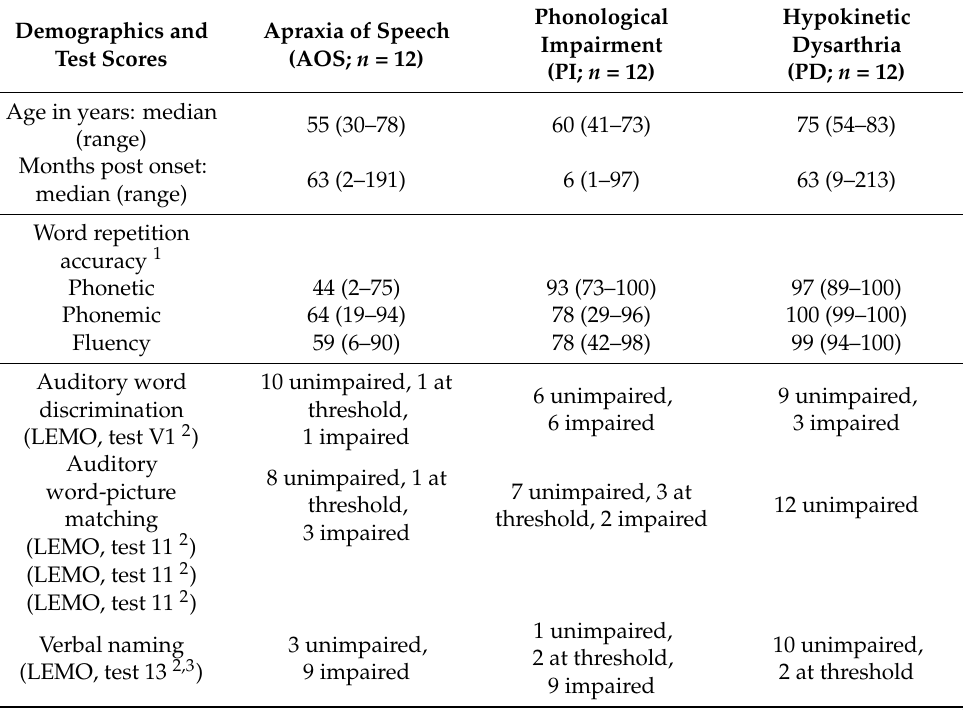
Table 1. Demographic details and clinical characteristics of the patient sample (12 patients with apraxia of speech, 12 patients with aphasia, 12 dysarthric speakers with